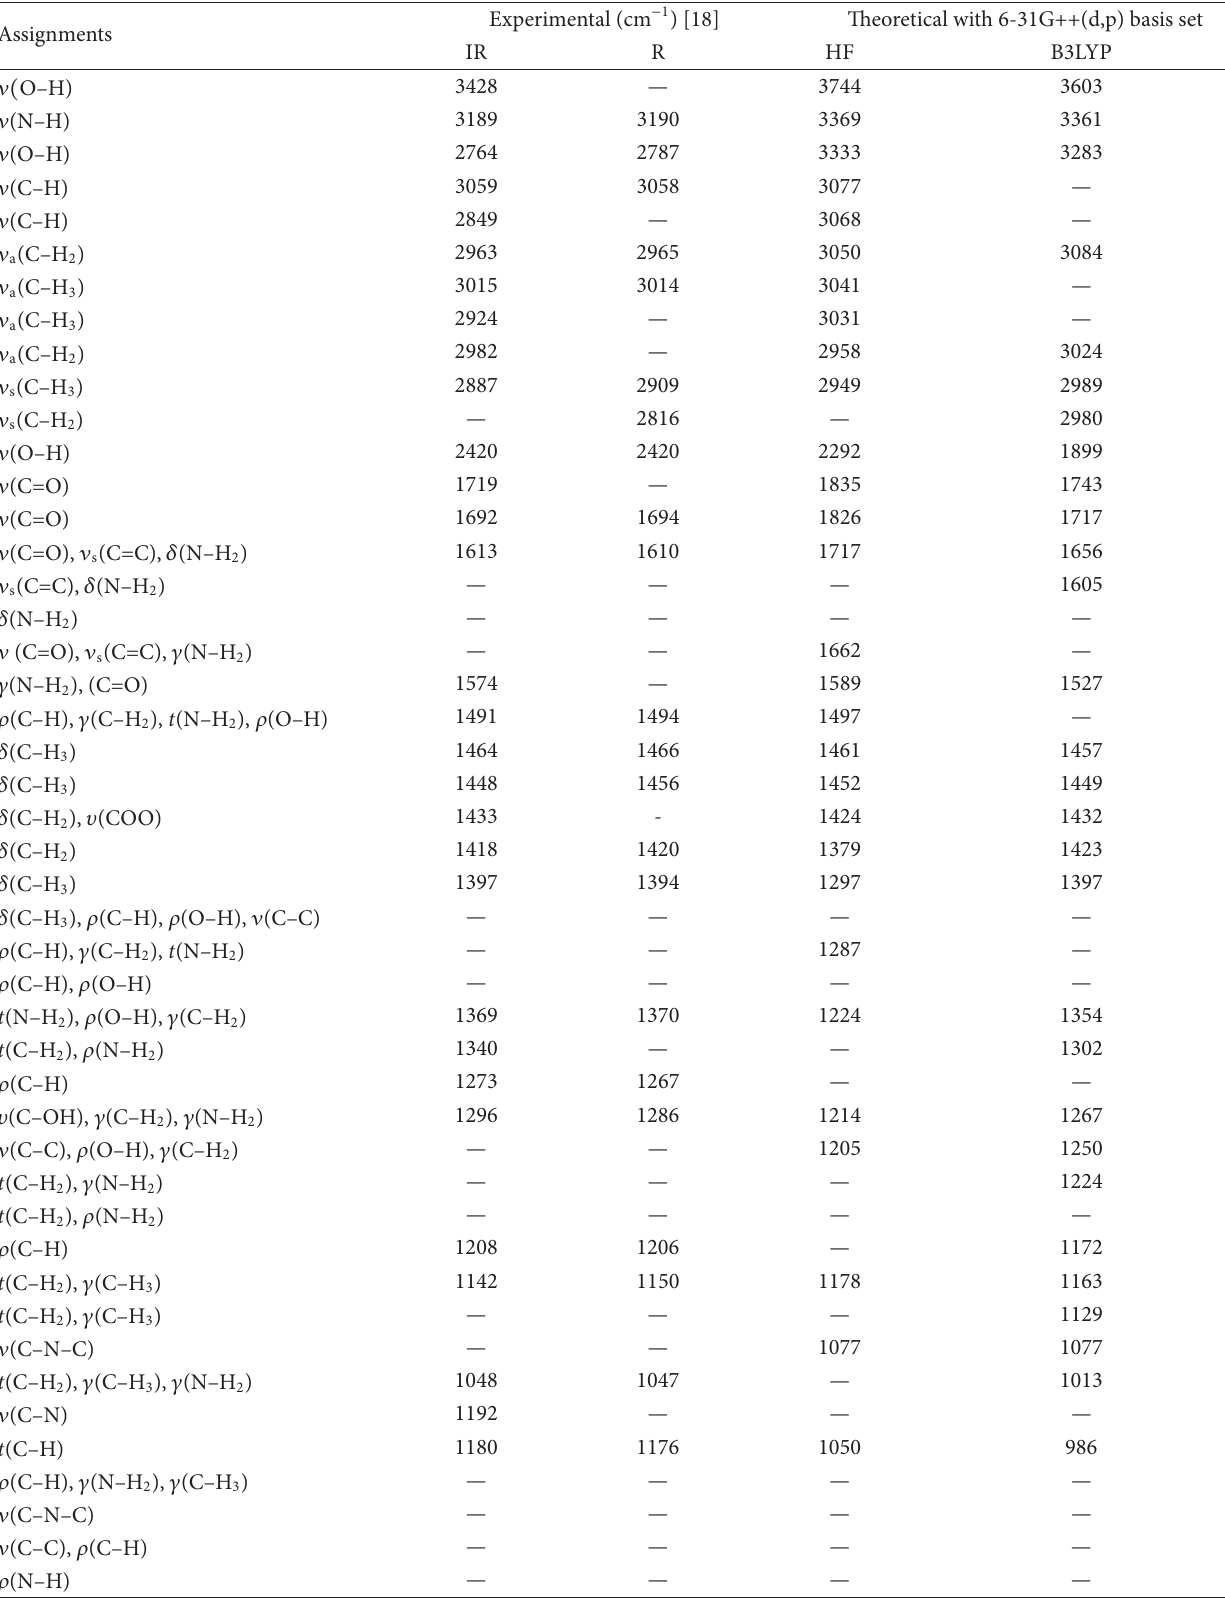
T 2: Comparison of the observed and calculated vibrational spectra for sarcosine-maleic